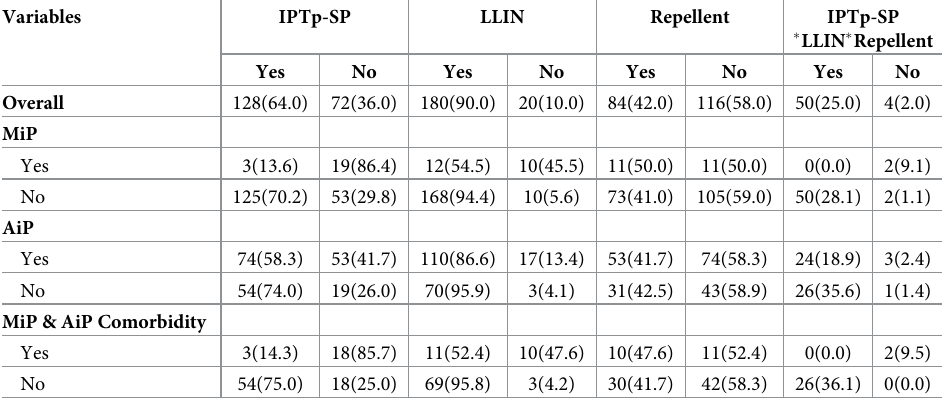
Table 2. IPTp-SP, LLIN and repellent use stratified by malaria, anaemia, and malaria/anaemia